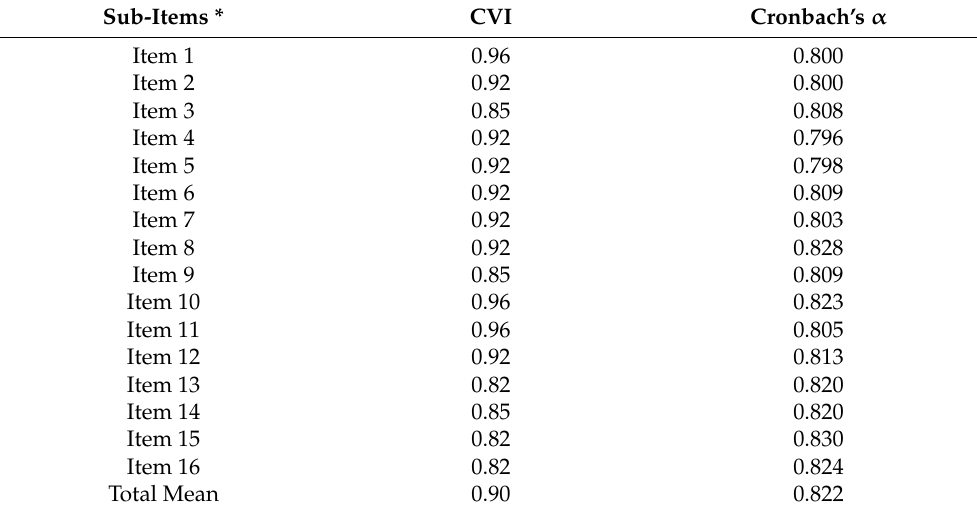
Table 2. Content validity and reliability of web-based MDSST ( n =